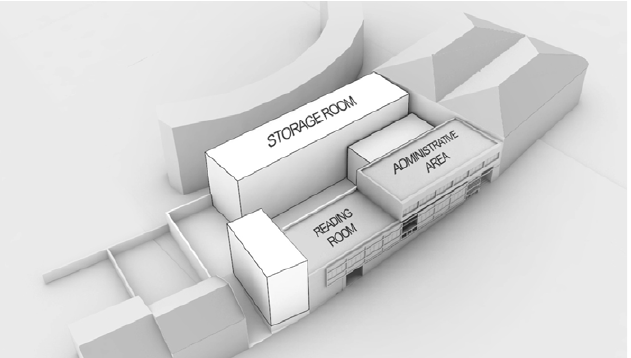
Figure 10. Proposed main program distribution in Abade Loureira